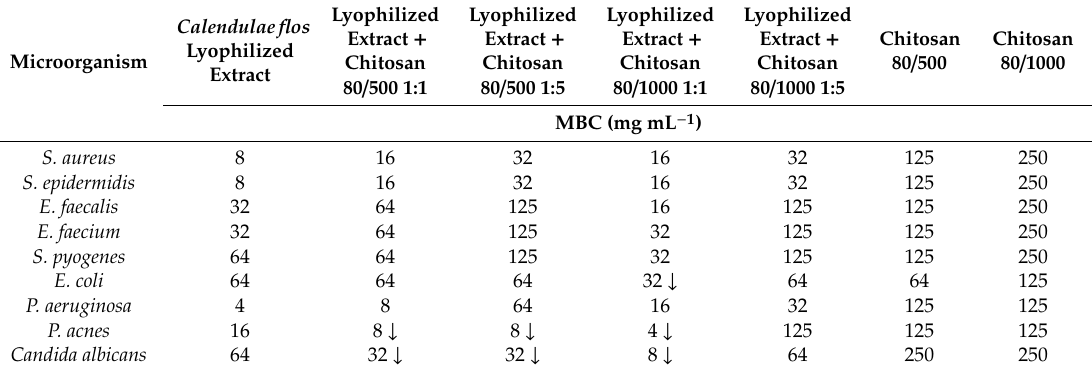
Table 4. Values of minimal bactericidal concentration of Calendulae flos lyophilized extract and its chitosan delivery systems against selected Gram ( + ) bacteria, Gram (-) bacteria, and fungi. Lyophilized Lyophilized Calendulaeflos Extract + Extract + Lyophilized Microorganism Chitosan Chitosan Extract 80 / 500 80 / 500 1:1